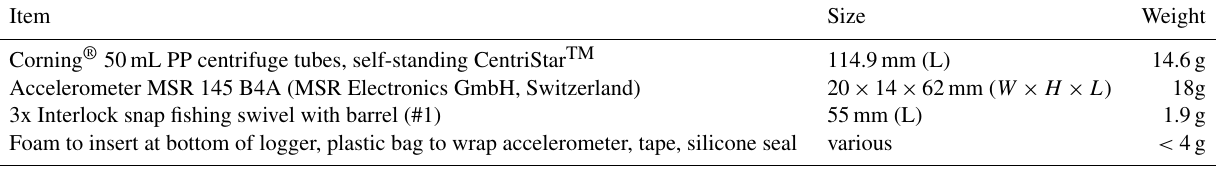
Table A1. Components of the Mini Buoy (without temperature and light loggers).